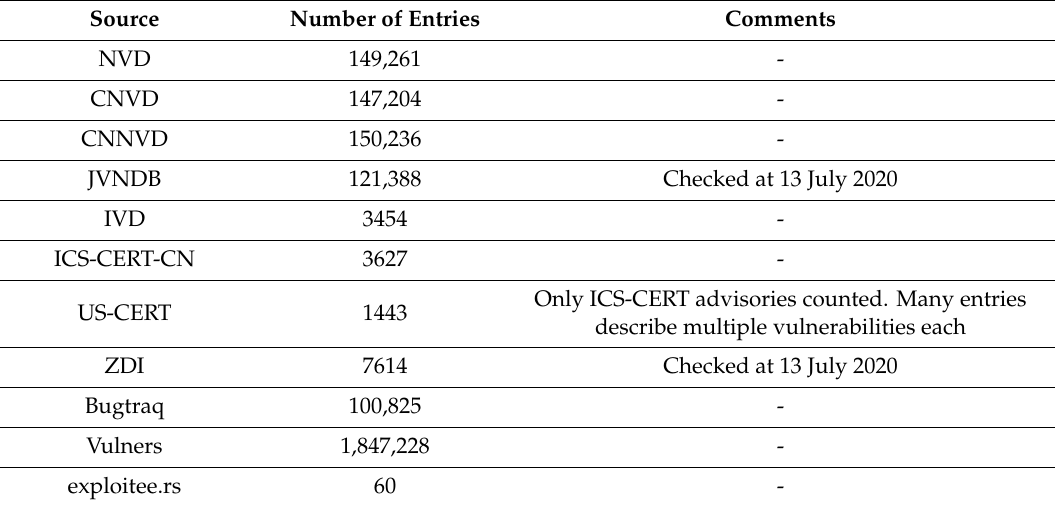
Table 11. Comparison of the number of entries found in each source.